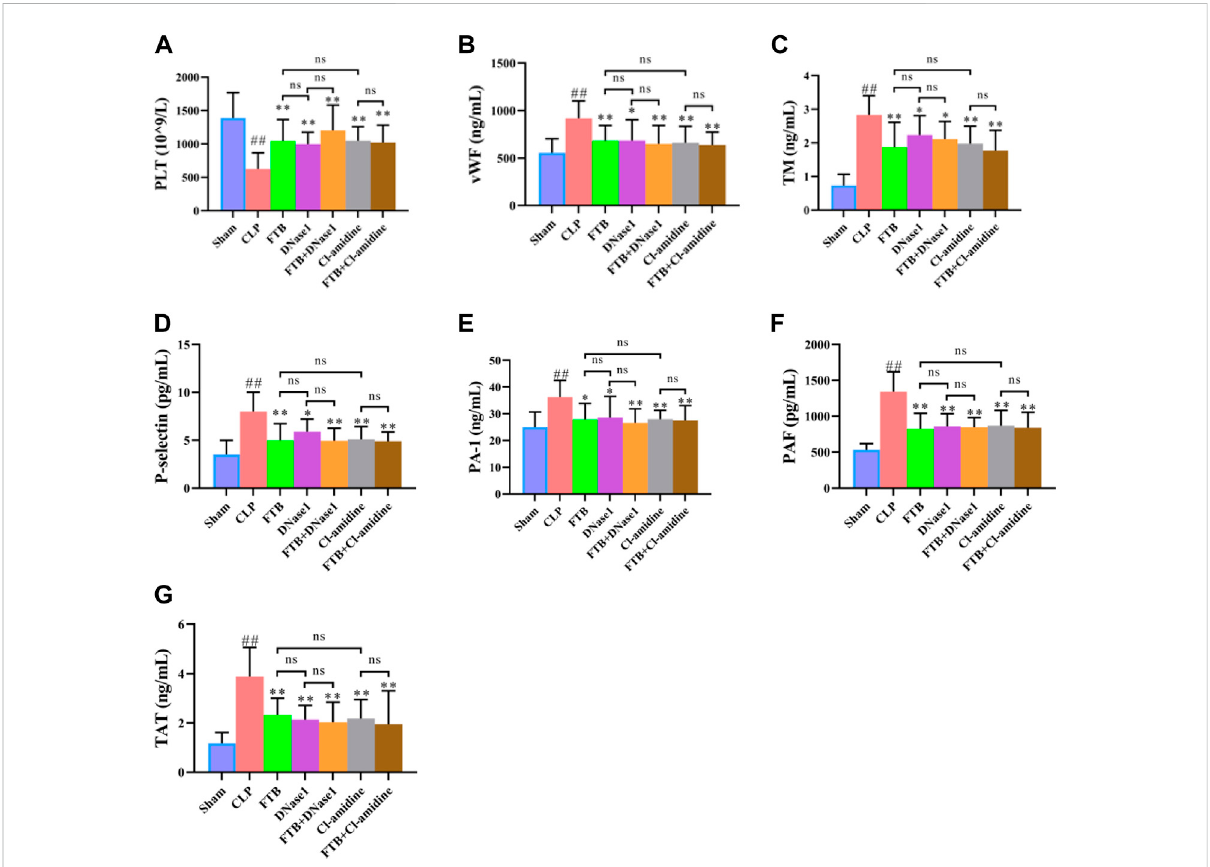
FIGURE 8 Effects ofFTBon coagulation function inratswith sepsisafter inhibitingtheNETformationand PAD4 activity.Inratswith sepsis, treatmentwith FTB, DNase1 (NETs inhibitor) and Cl-amidine (PAD4 inhibitor) increased the PLT count (A) , decreased the levels of coagulation factors [vWF (B) , TM (C) , P-selectin (D) , PAI-1 (E) , PAF (F) , TAT (G) ] and lowered the expression of thrombin in lung, liver and kidney (black arrows indicate the positive expression areas) (H,I) . However, no differences were observed in coagulation function between the FTB and DNase1 groups, FTB and Cl- amidine groups, DNase1 and FTB + DNase1 groups, and Cl-amidine and FTB + Cl-amidine groups (magni fi cation: ×100). Sham group ( n = 15), CLP group ( n = 8), FTB group ( n = 10), DNase1 group ( n = 9), FTB + DNase1 group ( n = 10), Cl-amidine group ( n = 10), FTB + Cl-amidine group ( n =